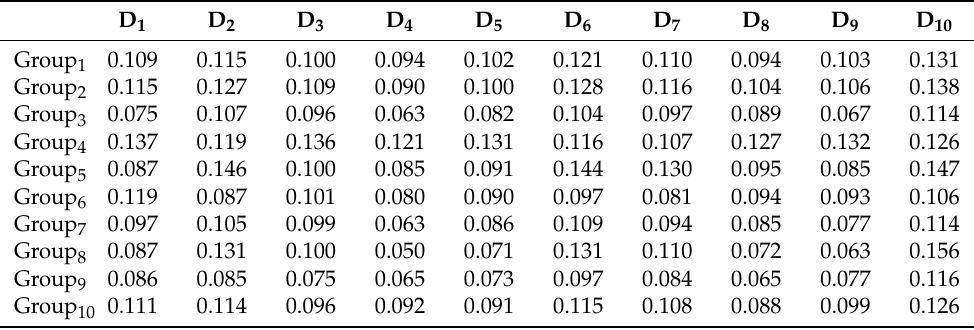
Table 11. Aggregated distances with the OWAD